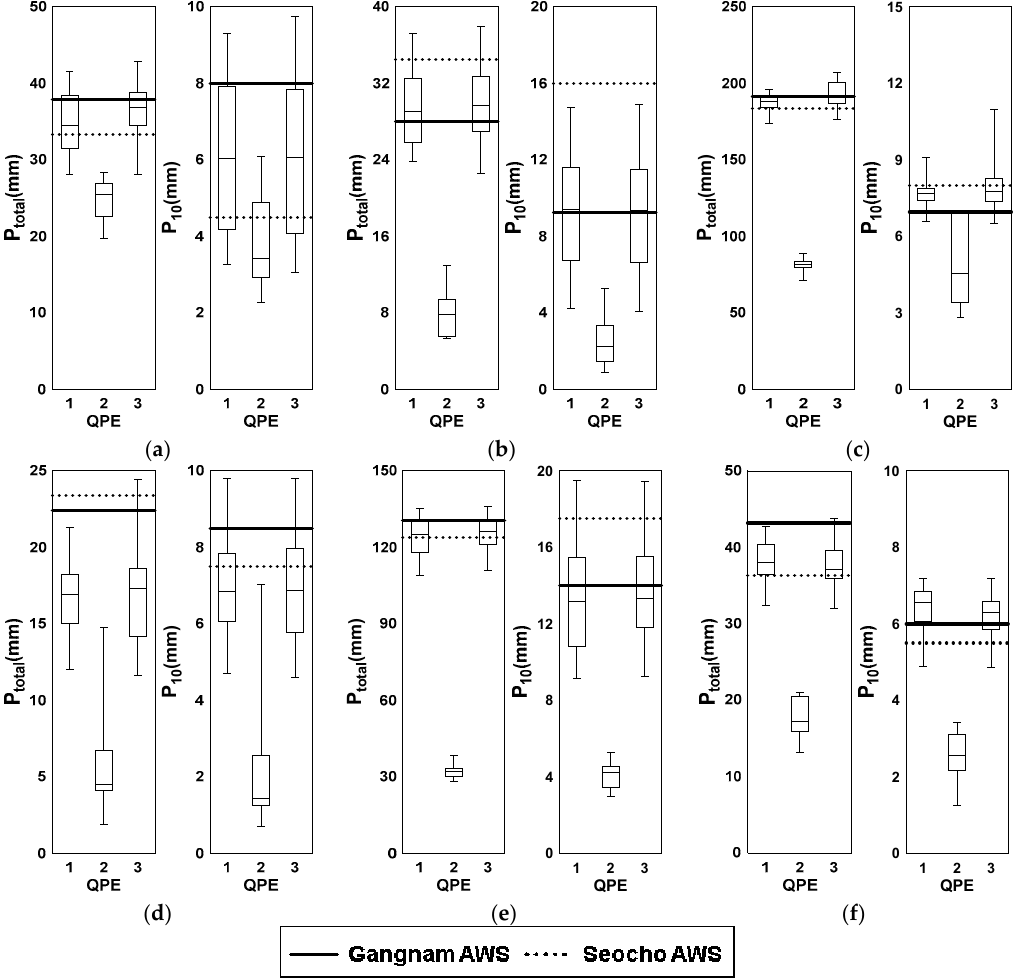
Figure 6. Distribution of Mean Areal Precipitation for 772 sub-basins: ( a ) 2 July 2013; ( b ) 4 July 2013;